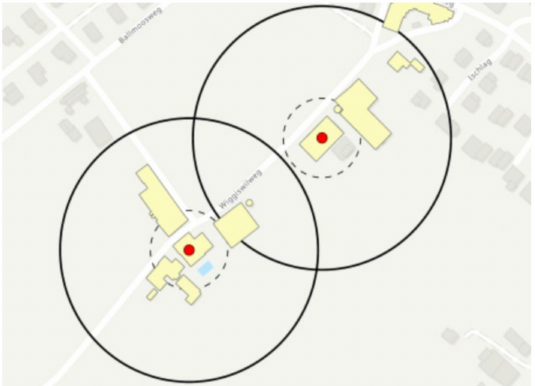
Figure 1. Identification and assignation of roofs within an agricultural setting relative to the closest farm to estimate the local PV